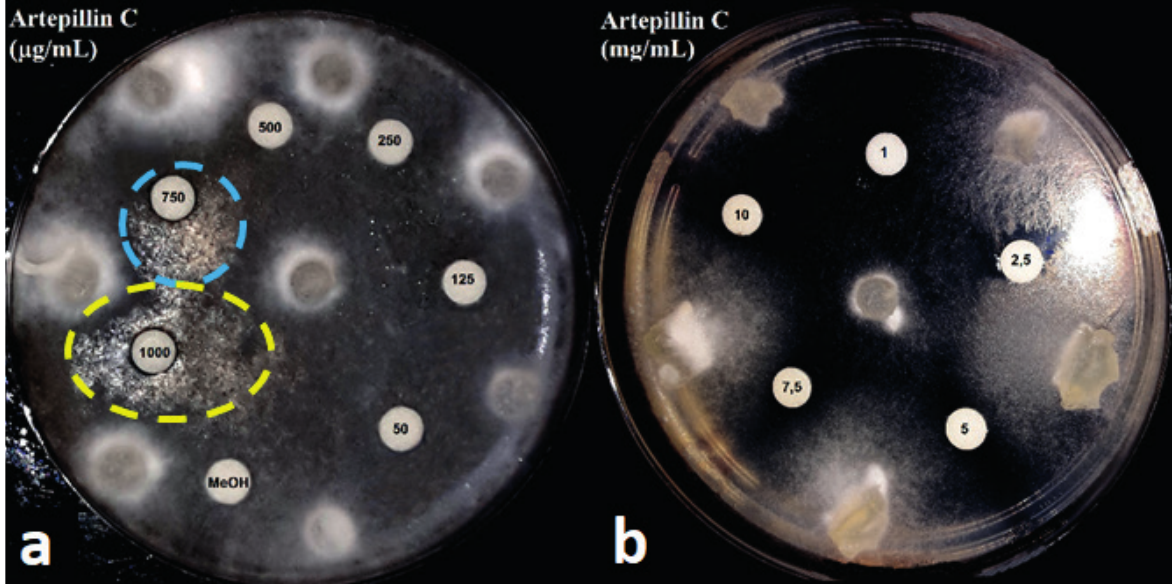
Figure 2 - Analysis of P. aphanidermatum growth in agar cup discs after 30 hours in the presence of Artepillin C. a ) Artepillin C concentrations ranging from 50 to 1000 µg.ml -1 and methanol (MeOH) as negative control (blue and yellow dashed circles represent the inhibition zone for 750 and 1000 µg.ml -1 , respectively); b ) Artepillin C concentrations ranging from 1 to 10 mg.ml -1 .